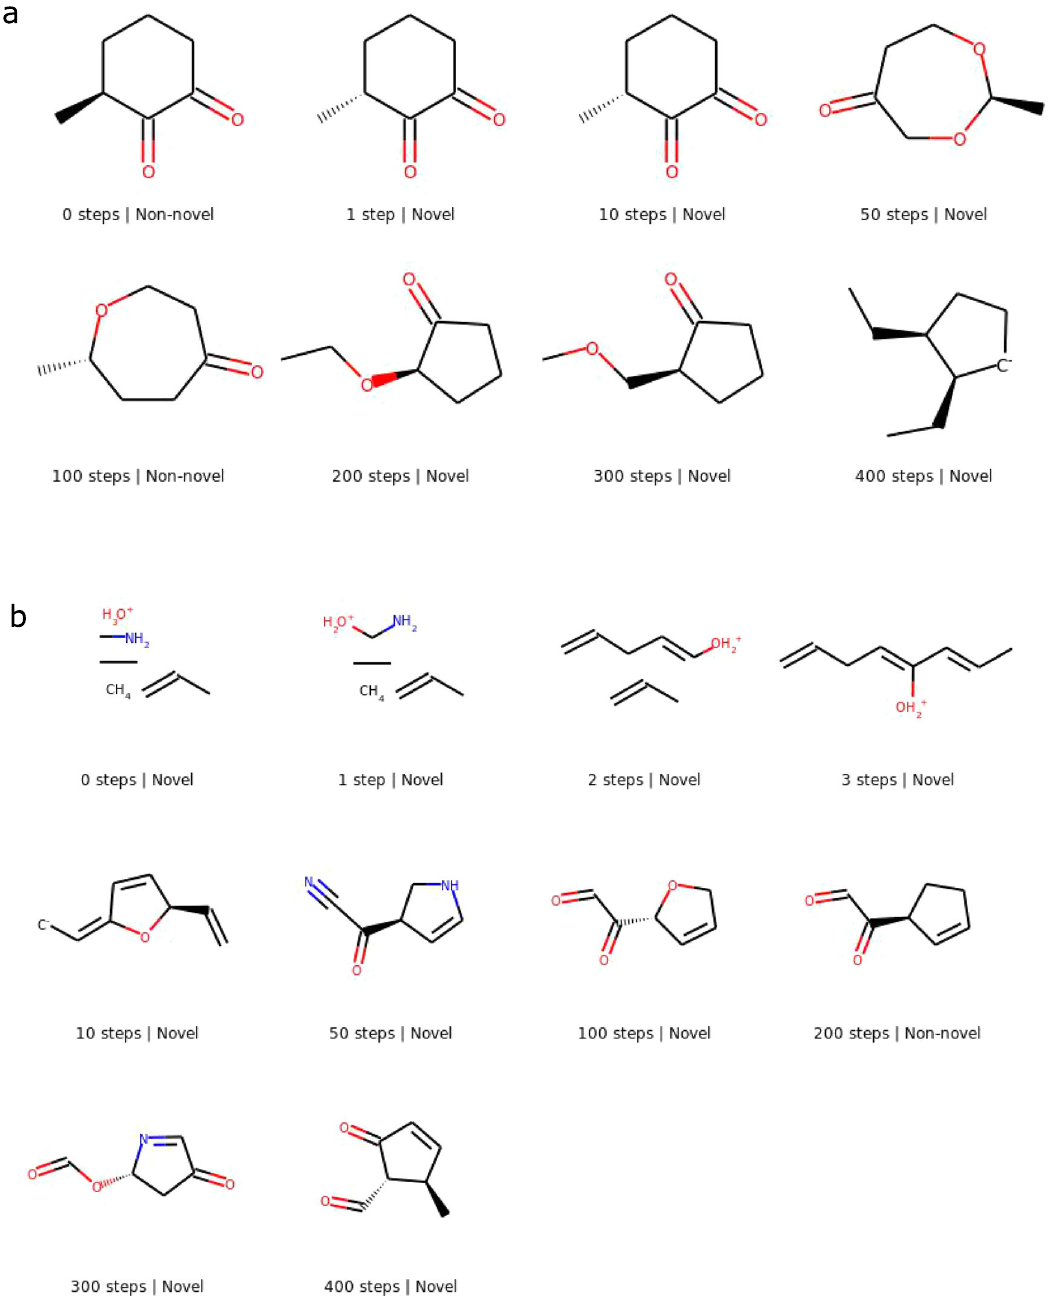
Fig. 2 Generation trajectory of a molecule each for training initialization and marginal initialization. The model is trained on QM9, and generation is carried out using a 10% masking rate. a Training initialization. b Marginal